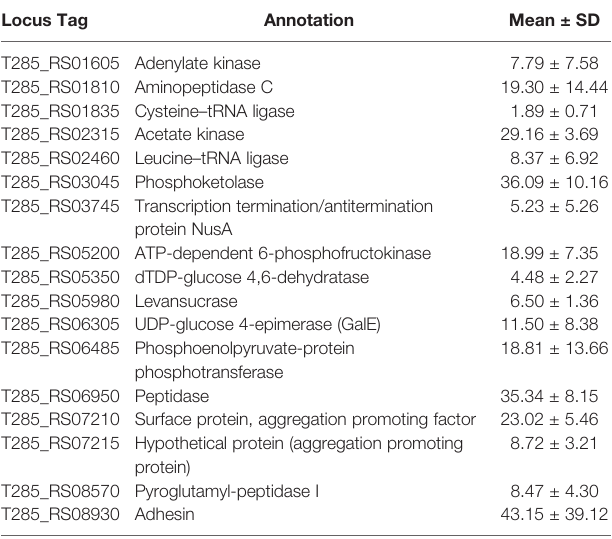
TABLE 5 | Proteins uniquely identi fi ed in the NV of L. johnsonii N6.2. Locus Tag